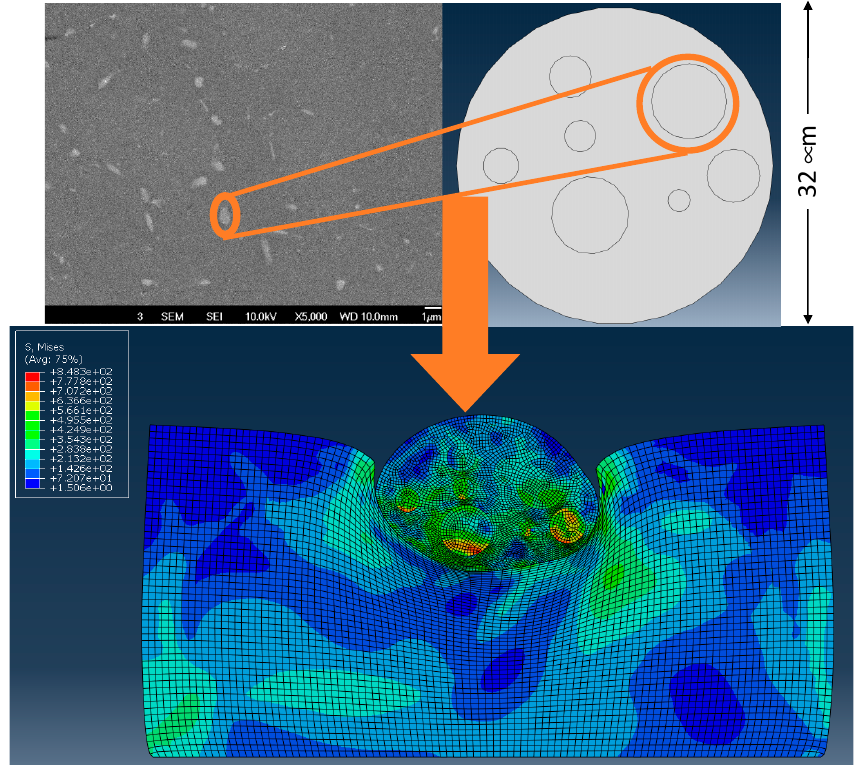
Figure 12 . Finite element analysis (FEA) single-particle impact simulation using secondary phases of high hardness.